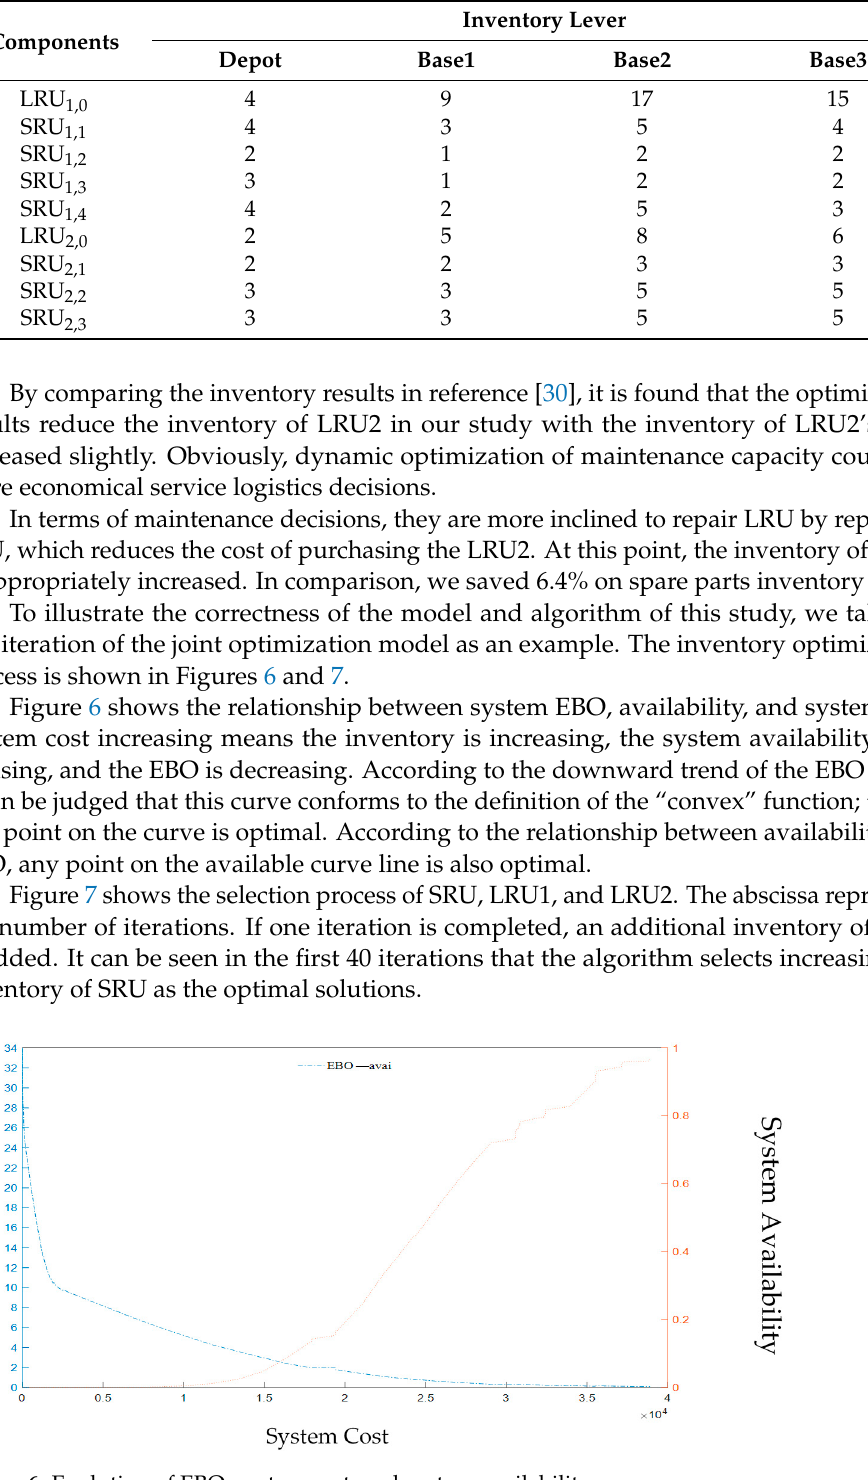
Figure 6. Evolution of EBO, system cost, and system availability.